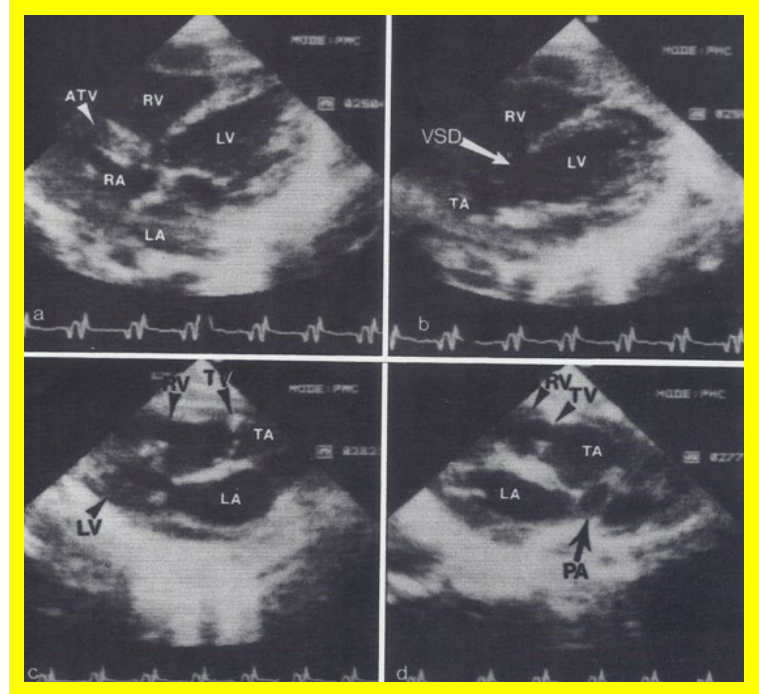
Figure 13. Two dimensional echocardiographic video frames demonstrating ( a ) an atretic tricuspid valve (ATV) between the right atrium (RA) and right ventricle (RV), ( b ) a large subtruncal ventricular septal defect (VSD), ( c ) thickened and somewhat domed truncal valve (TV) leaflets, and ( d ) the origin of the pulmonary artery (PA) from the posterior aspect of the truncus arteriosus (TA). LA, left atrium; LV, left ventricle. Reproduced from Rao PS, et al. Am Heart J 1991;122:829-835 [31].